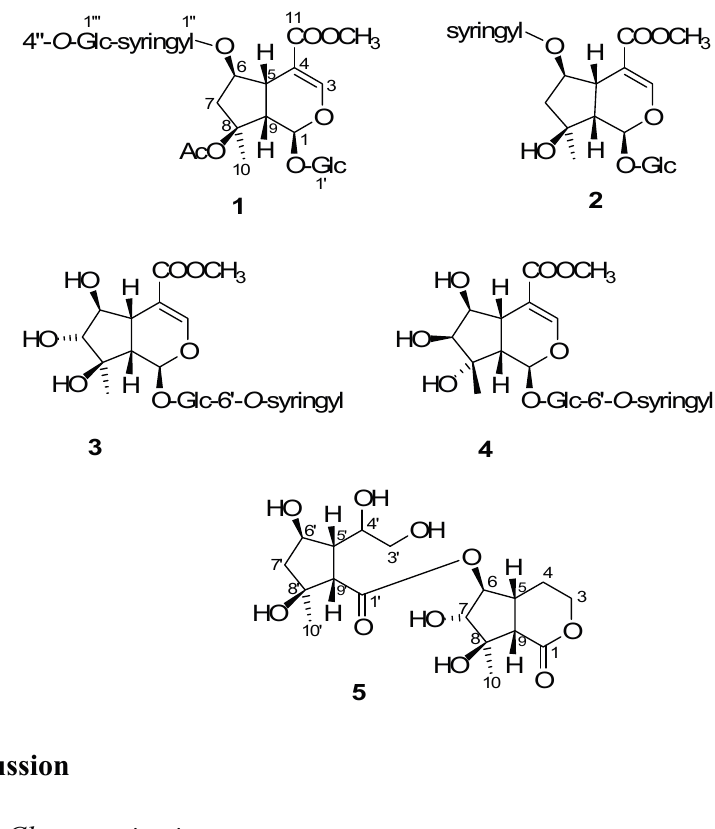
Figure 1. Structure of the new compounds 1 – 5